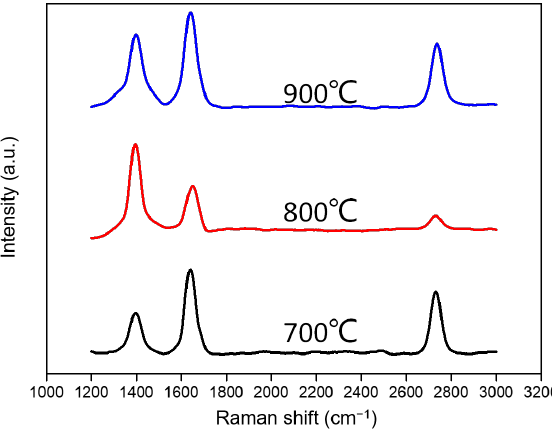
Figure 5. Raman spectrums of benzene-grown graphene at 700~900 °C.